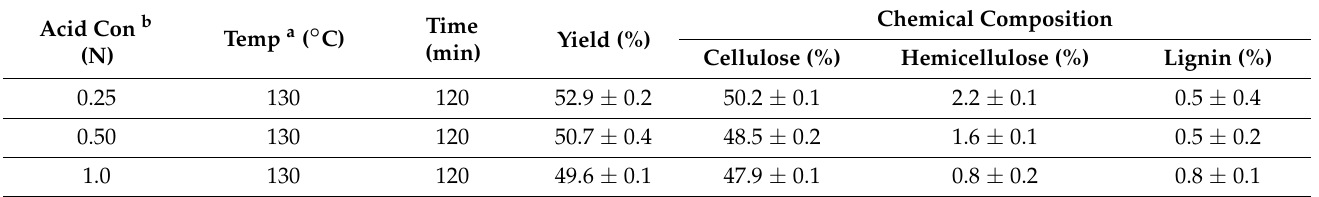
Figure 3. Different acid concentrations of sulfuric acid hydrolyze different xylan in the hemicellulose of kenaf outer bast by NMR spectrum. Table 3. Chemical composition of kenaf outer bast with a different acid concentration of acid hydrolysis.